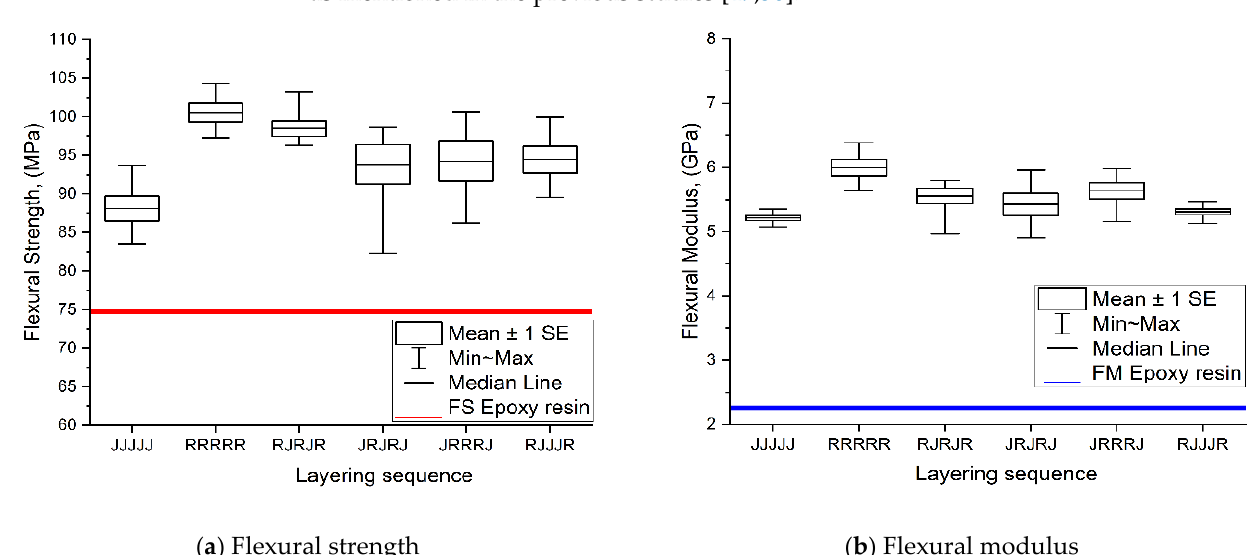
Figure 5. Flexural strength ( a ) and flexural modulus ( b ) of single and hybrid jute–ramie woven composites.